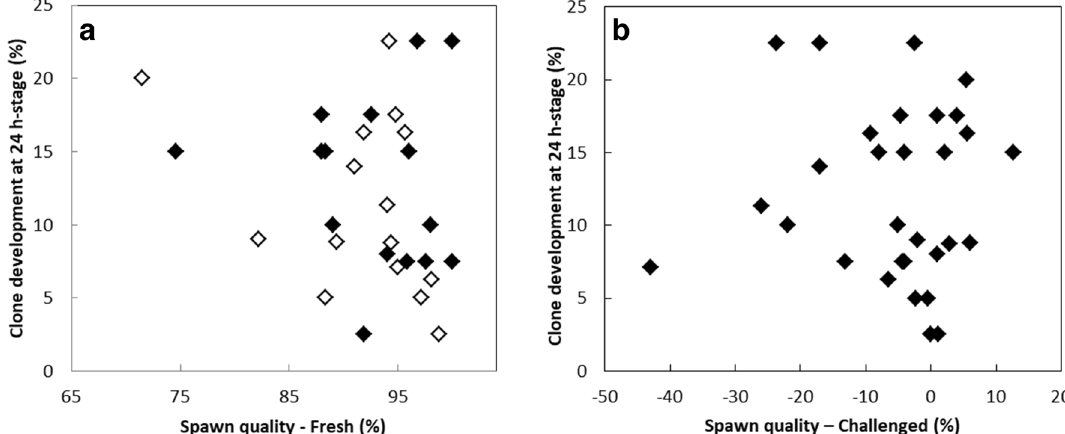
Figure 1. Clone development rate at 24 h-stage in relation with two spawn quality criteria estimated from: ( a ) embryo development 24 h after standard fertilization of freshly collected oocytes (Spawn quality-Fresh) and ( b ) difference of development rate at 24 h between oocytes that were fertilized just after collection and those from the same batch fertilized 2 h after an in vitro storage challenge at 10 °C (Spawn quality-Challenged). Clone development rate was assessed 24 h after nuclear transfer with 2 different fin cell culture batches (open and closed diamonds). Oocytes from the same spawn were used for clone development and spawn quality assessment (n = 30 different spawns). Each value (%) corresponds to 80 nuclear transferred oocytes and 200–250 fertilized oocytes. No significant correlation was observed whatever the spawn quality criteria (r < 0.35; p >